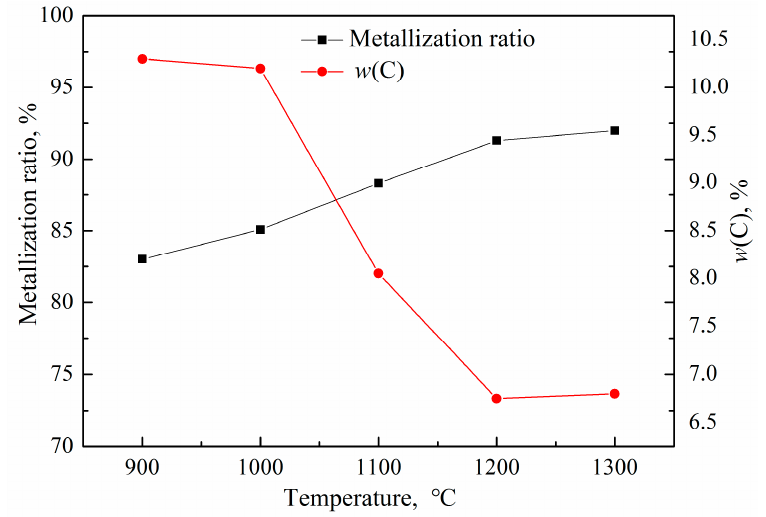
Figure 6. Effect of roasting temperature on metallization ratio and residual carbon.